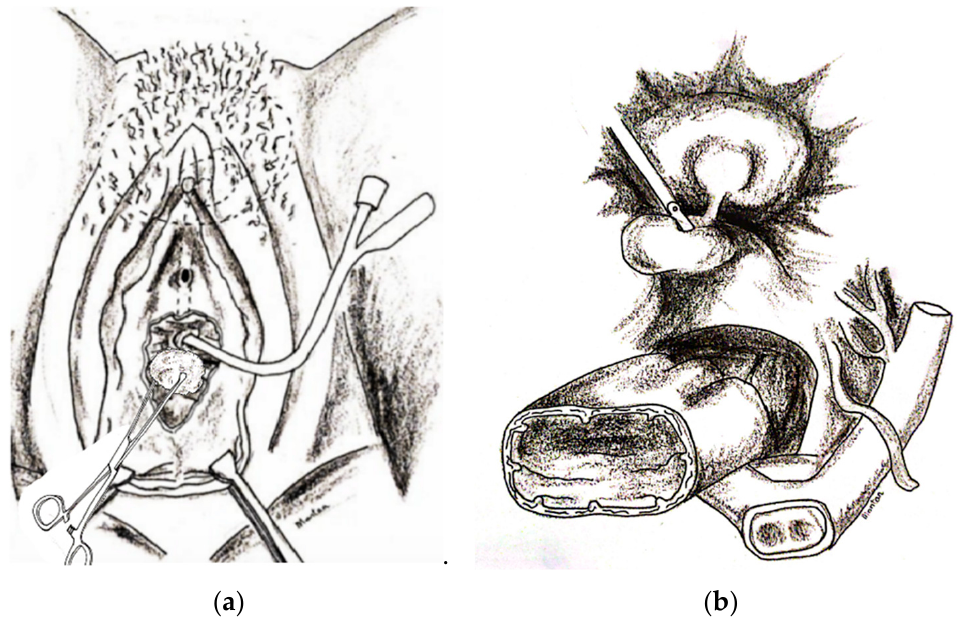
Figure 2. ( a ) The vaginal vault was exposed by a vaginal pressure with a gauze pad or with a bowel dilator inserted into a glove. ( b ) Laparoscopic view with exposure of VVF after careful adesiolysis and tissue dissection between bladder and vaginal vault.